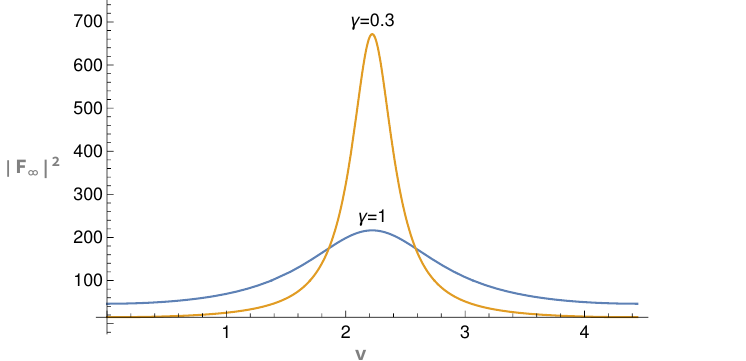
p Figure 4. Plot of j F 1 ( v ) j 2 for v 2 [0 ; 2 (cid:25) ) where F is proportional to a Cauchy distribution (4.16) p with (cid:13) as labeled and (cid:20) = (cid:25)= 2. where we de(cid:12)ne (cid:14)Q ( v ) through (3.22), then we see that for small (cid:13) P